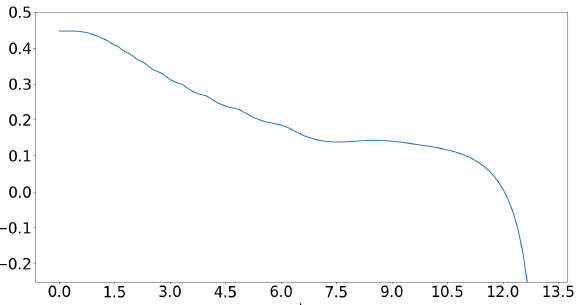
Figure 19. Our expansion rate H along z = 0 where boundary conditions were chosen using Equation (32) and with λ =